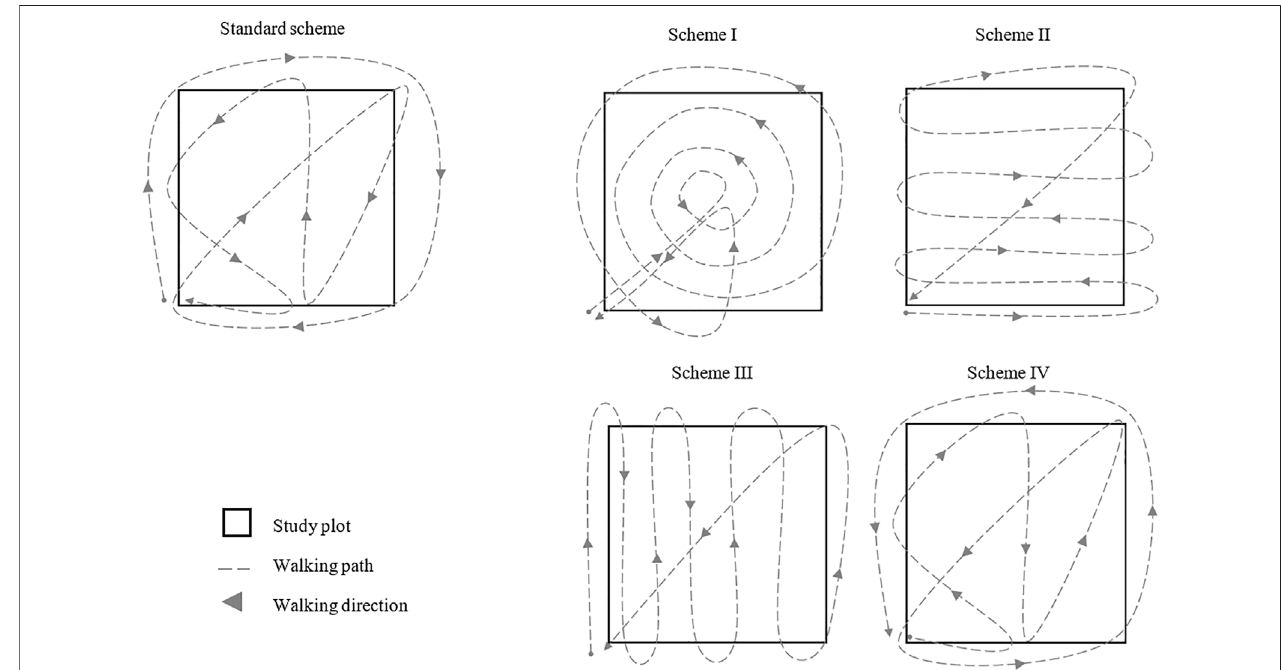
FIGURE 2 | Measuring schemes from the standard design for quantifying the reproducibility and the seasonal changes in forest structural complexity (standard scheme) and from the scansmade through the course of 1 h with four further different walking paths to quantify the differences between the repeated measurementsat the same site (scheme I –